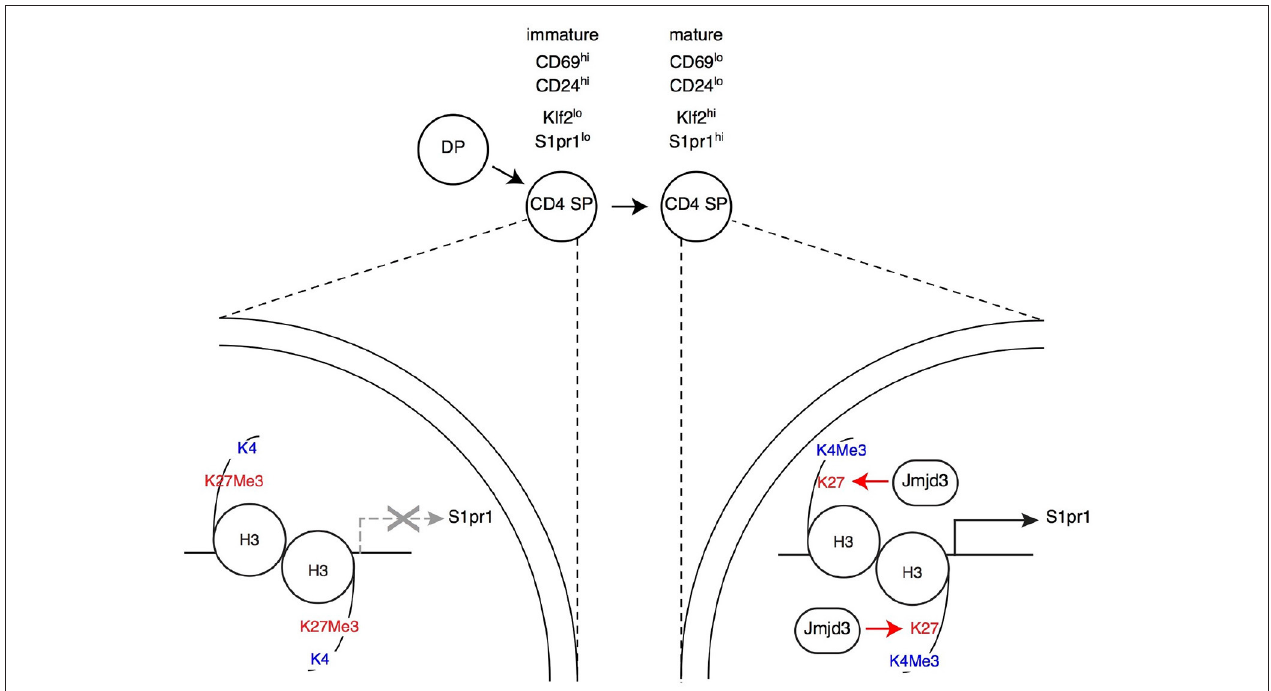
FIGURE 3 | Impact of H3K27Me3 demethylation on late thymocyte differentiation Immature SP thymocytes (characterized by their expression of surface markers CD69 and CD24, as indicated) have low expression of the surface receptor S1pr1 (needed for thymic egress) and of the transcription factor Klf2 (needed for S1pr1 expression). Expression of both genes increases in mature SP thymocytes, allowing their export to the bloodstream and secondary lymphoid organs. In immature SP cells, the promoters of S1pr1 and Klf2 are enriched in the repressive H3K27Me3 mark, whereas the “active” H3K4Me3 mark is absent ( left , depicted here for S1pr1 ). Thymocyte maturation is accompanied by an inversion of this pattern at both genes (right) . The H3K27Me3 demethylase Jmjd3 (with functional overlap with the related protein Utx, not depicted) is needed to “erase” the H3K27Me3 mark at S1pr1 , for S1pr1 expression and for thymic egress. Note that Jmjd3 is expressed at similar levels in both mature and immature SP cells (not shown in the latter for simplicity), suggesting that it is recruited to target genes through interactions with sequence-specific transcription